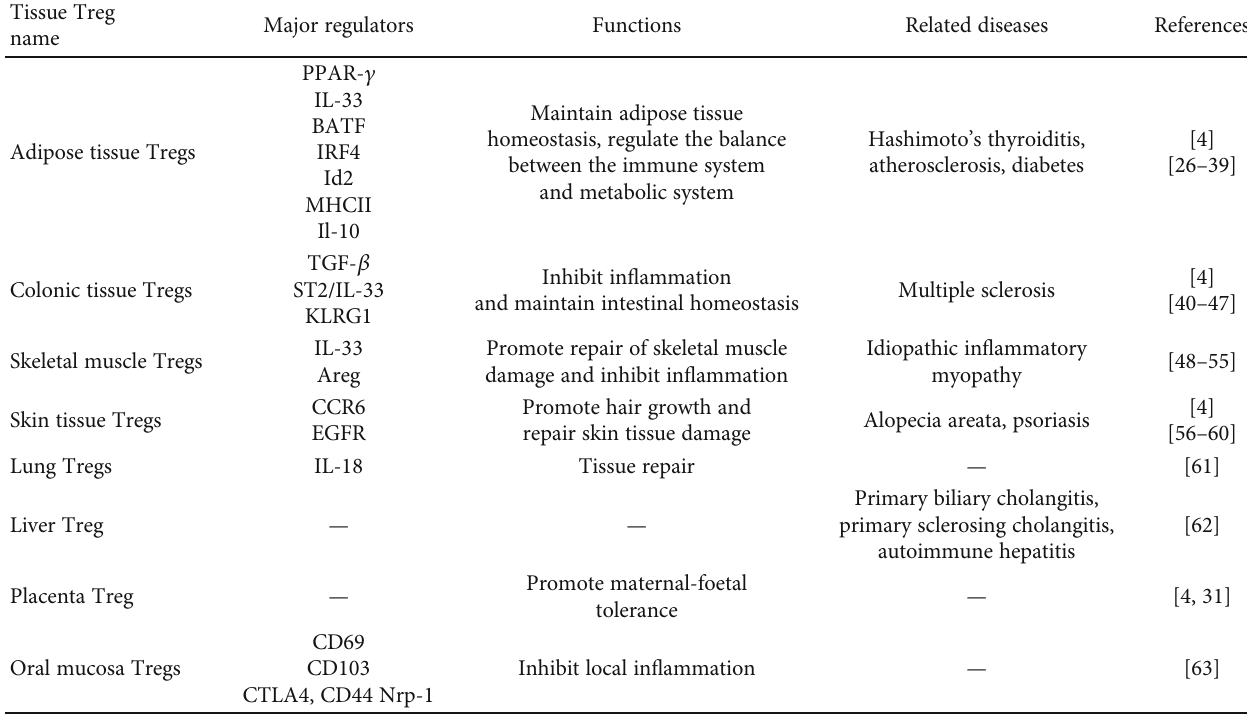
Table 1: Types, regulatory molecules, functions, and related autoimmune diseases of tissue Tregs. Tissue